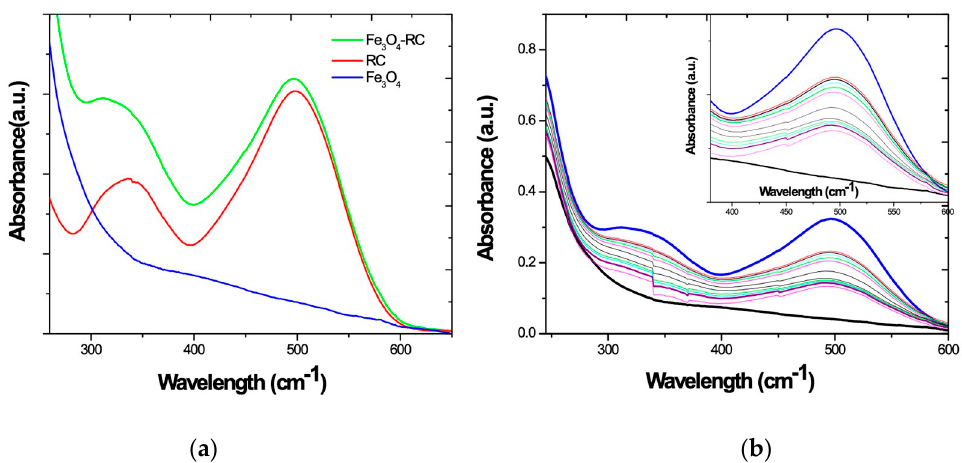
Figure 7. Uv-vis spectra of the ( a ) Fe 3 O 4 NPs, the Fe 3 O 4 NPs-CR, and the CR (40 mgL − 1 ) and ( b ) Congo red photodegradation by Fe 3 O 4 NPs synthesized using Cnicus benedictus